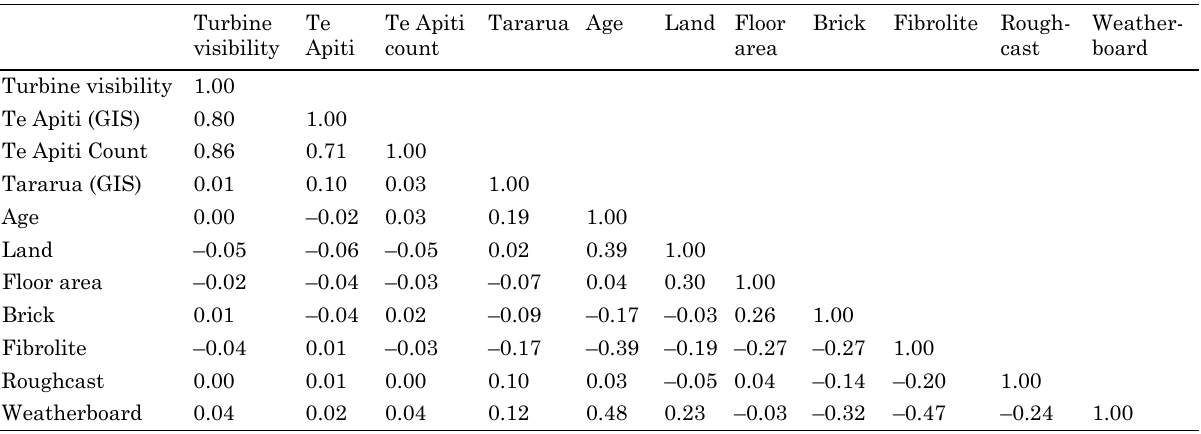
Table 3. Correlations for different sub-samples Panel A. Ashhurst data for the period 1995 to